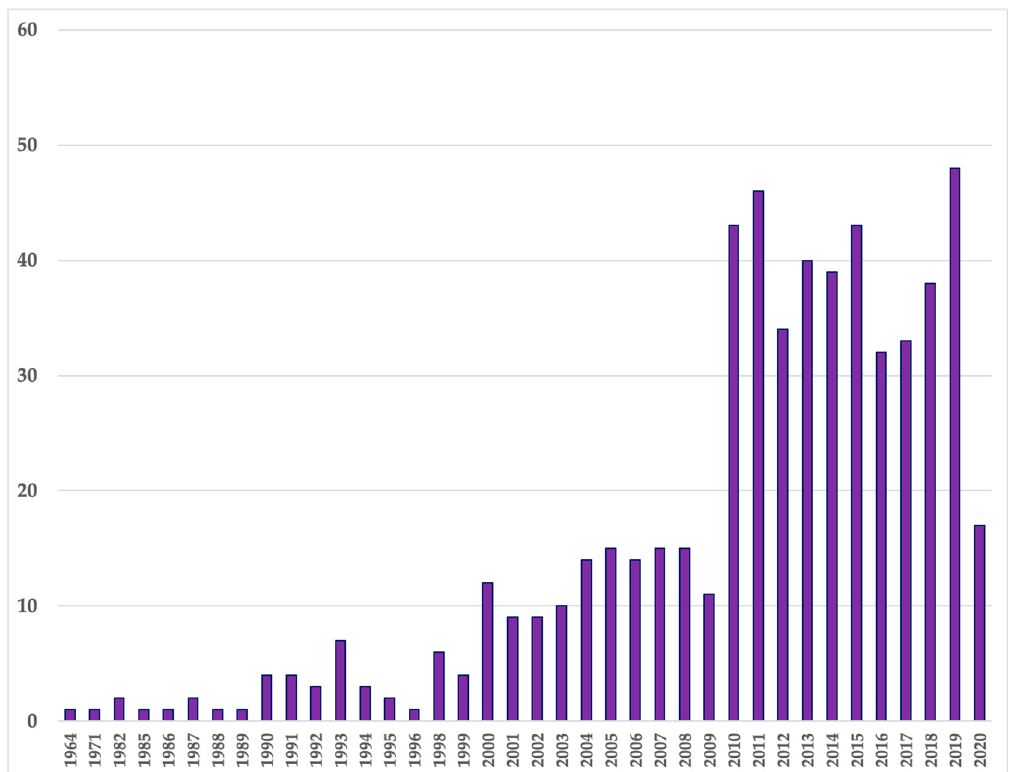
Figure 1. Publication frequencies by type of publication outlet. Source : Author compilation.